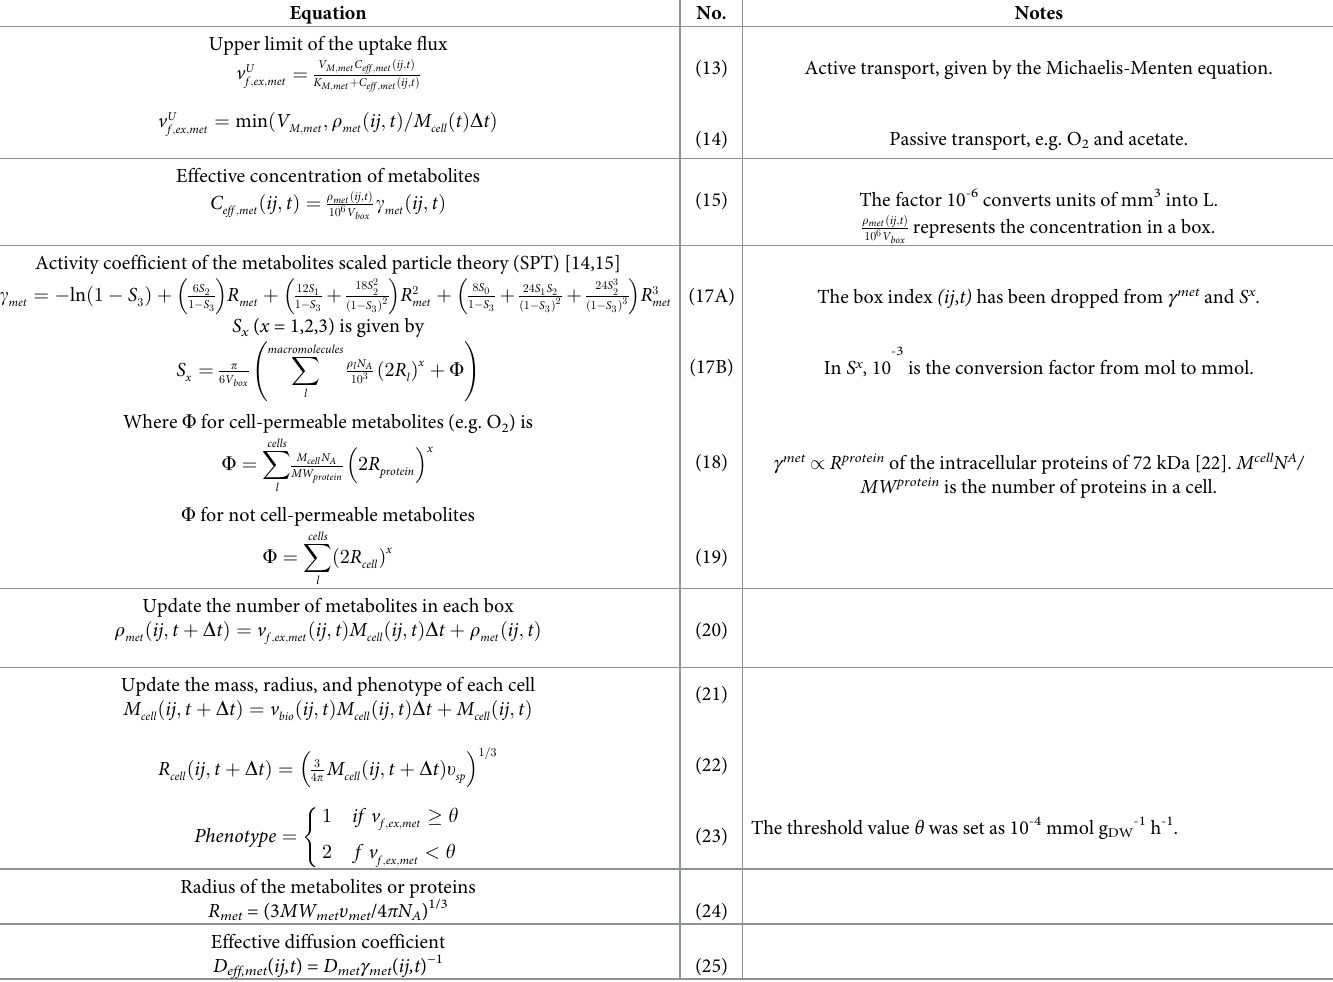
Table 3. Complementary equations used by CROMICS for the spatio-temporal simulation of microbial systems. Equation No. Notes